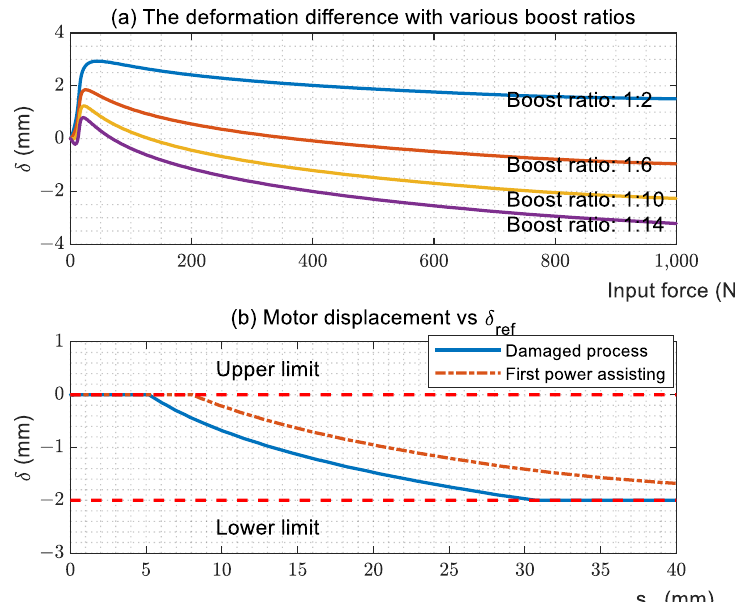
Figure 7. The target delta according to the boost